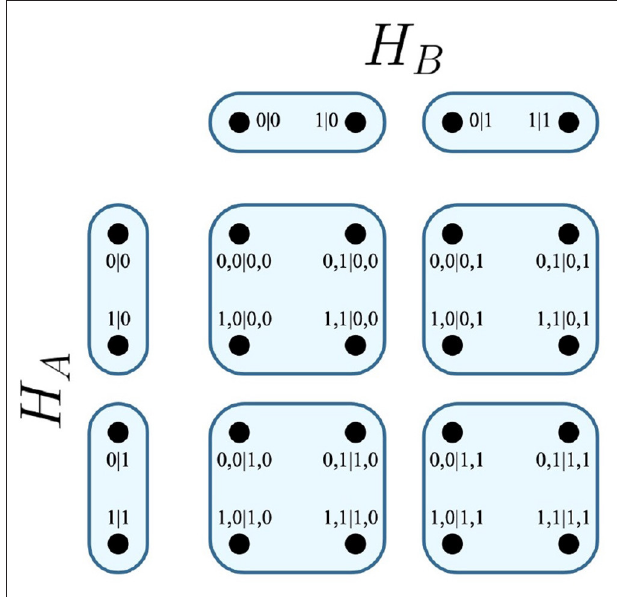
FIGURE 1 | Cartesian product of contextuality scenarios H A and H B